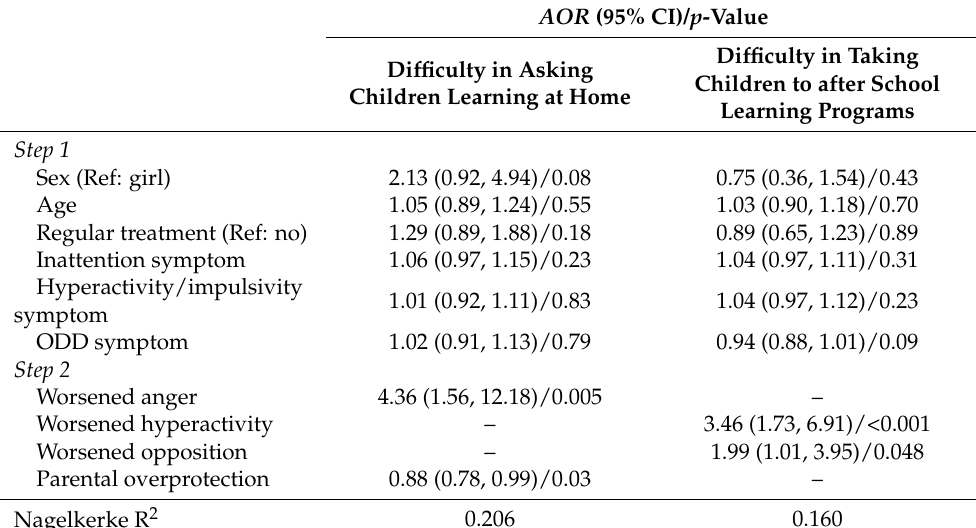
Table 3. Factors explaining caregivers’ difficulties in managing ADHD children’s learning in the binary logistic regression